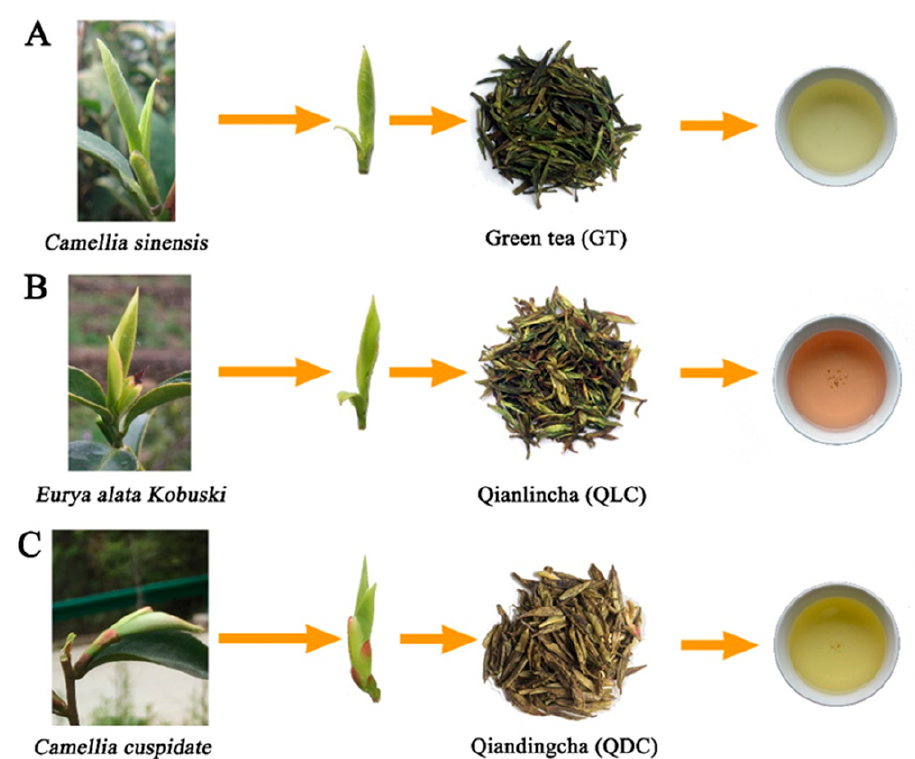
Figure 1. Morphological differences in the buds and tea samples from three theaceae plants (( A ), C. sinensis and GT; ( B ), C. cuspidata and QLC; and ( C ), E. alata Kobuski and QDC).